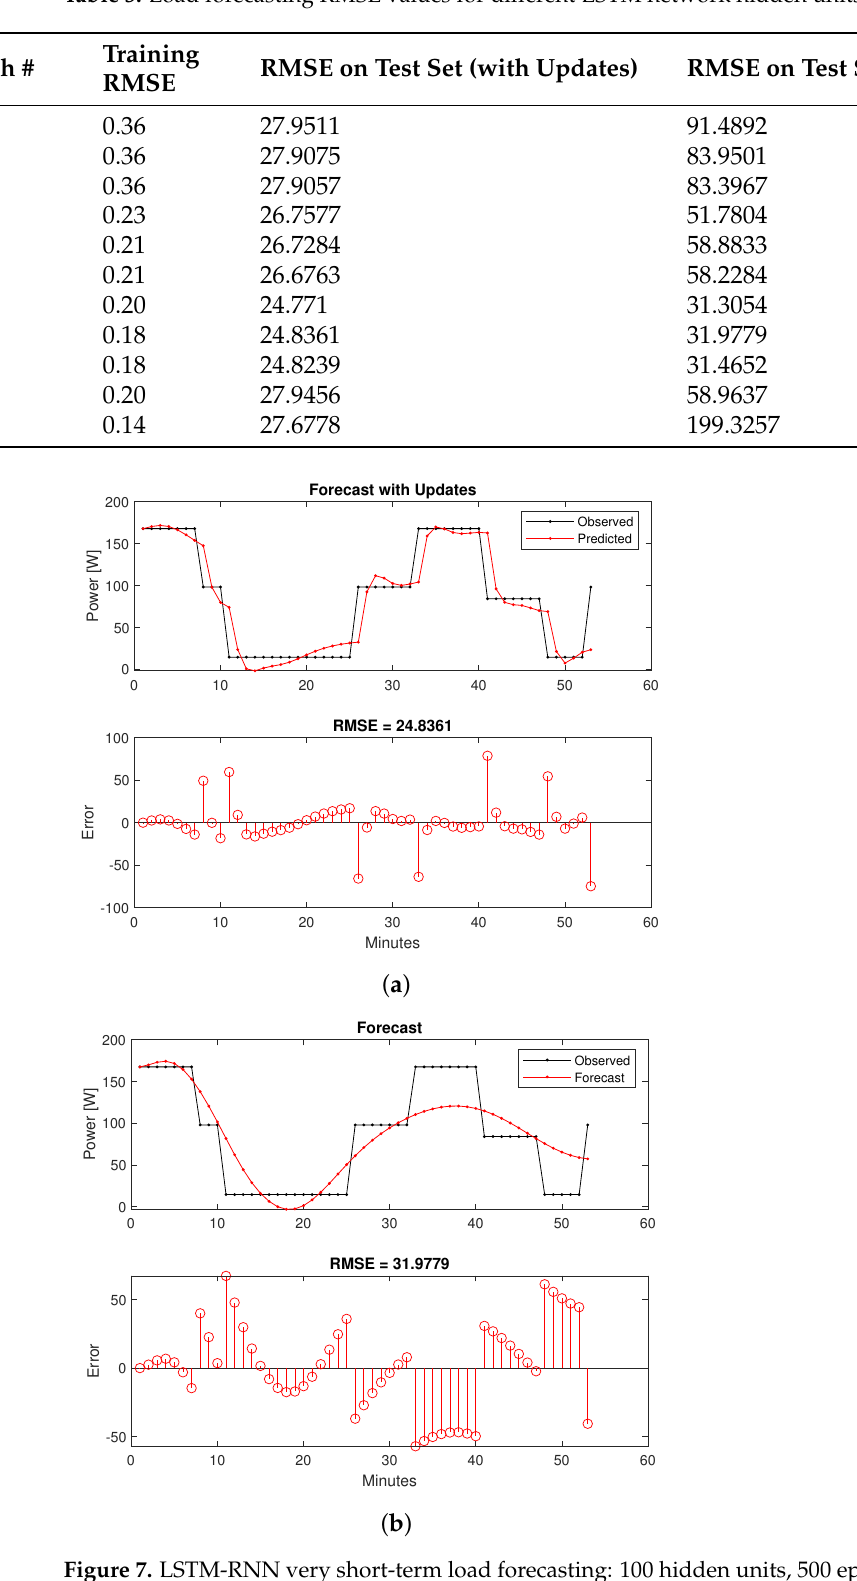
Table 3. Load forecasting RMSE values for different LSTM network hidden units and epoch #.